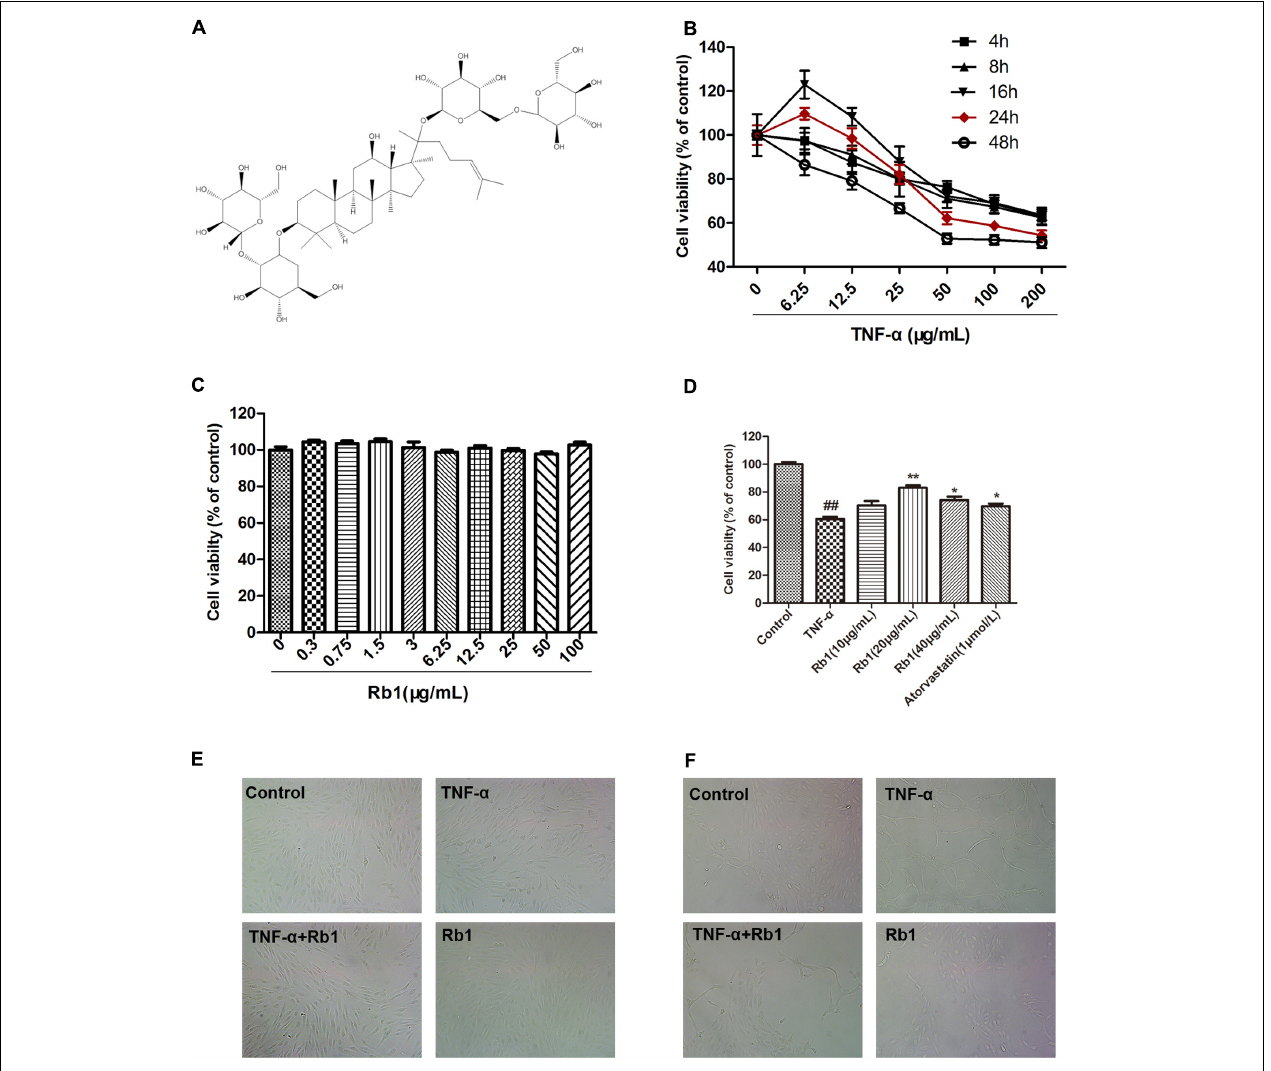
FIGURE 1 | Ginsenoside Rb1 protected human umbilical vein endothelial cells (HUVECs) against tumor necrosis factor- α (TNF- α )-induced injury. (A) The chemical structure of ginsenoside Rb1. (B) HUVECs were treated with TNF- α (6.25, 12.5, 25, 50, 100, and 200 µ g/mL) for different time intervals (4, 8, 16, 24, and 48 h). Cell viability was detected by MTT assay. (C) Ginsenoside Rb1 treatment alone has no toxic effect on the cell viability of HUVECs. (D) HUVECs were pretreated with Rb1 (10, 20, and 40 µ g/mL) or atorvastatin (1 µ mol/L) for 8 h and then incubated with TNF- α for 24 h. Cell viability was detected by MTT assay. (E) HUVECs were pretreated with Rb1 (20 µ g/mL) for 8 h and then incubated with TNF- α for 24 h. Morphological images were obtained using an inverted microscope connected to a digital camera. (F) Matrigel was added to each well, and HUVECs were cultured and exposed to TNF- α for 24 h after incubation with Rb1 (20 µ g/mL) for 8 h. Morphological images of tube formation in HUVECs were captured using the inverted microscope. Data were expressed as the mean ± SD of three independent experiments. ## P < 0.01 vs. control group; ∗ P < 0.05, ∗∗ P < 0.01 vs. TNF- α treatment